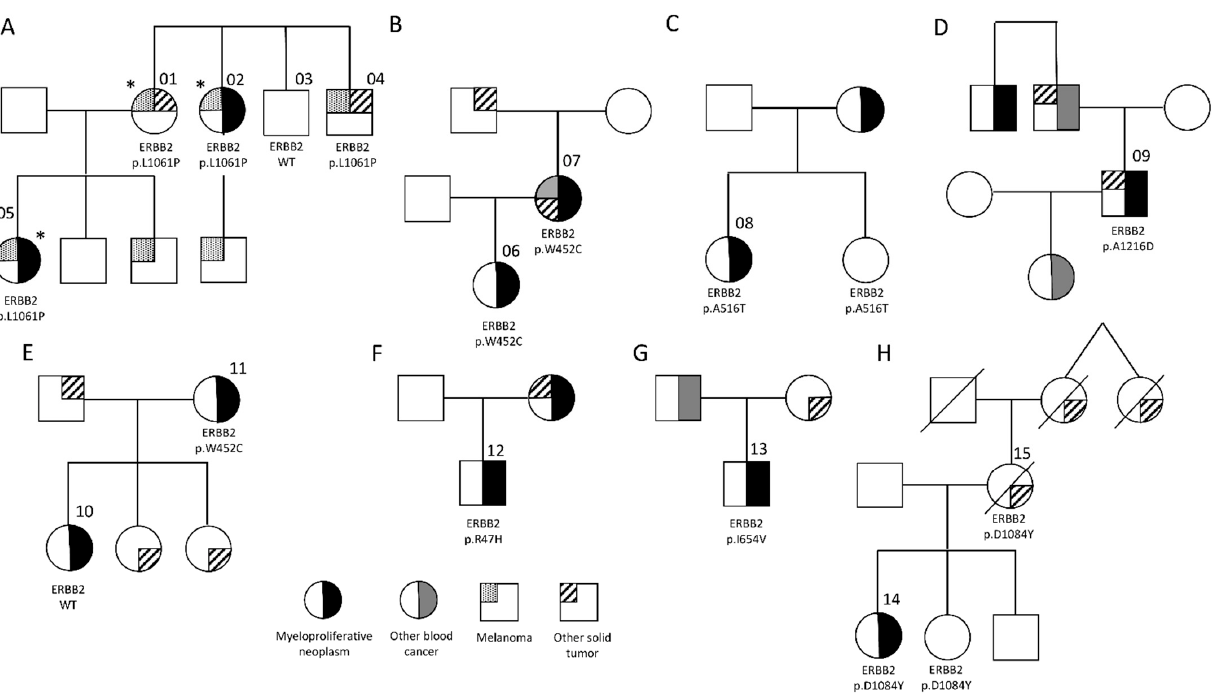
Figure 1. Pedigrees of families with inherited MPN. ( A ) Exome sequencing of the three family members marked with an asterisk (*) was performed in order to identify the predisposing inherited variant in this family. Sequence analysis produced a shared heterozygous variant in the gene ERBB2 . Genotyping of two additional family members for the ERBB2 c.3182T > C; p.L1061P variant established that it co-segregates with the cancer phenotype. ( B–G ) Pedigrees of the 6 additional cases of familial MPN found to have germline ERBB2 variants. ( H ) An MPN case with a germline ERBB2 c.3250G > T; p.D1084Y variant was noted to have a family history of breast cancer in her mother, who also carried this variant. Her sister was identified as an unaffected carrier. See Table S1 for additional pedigree information.